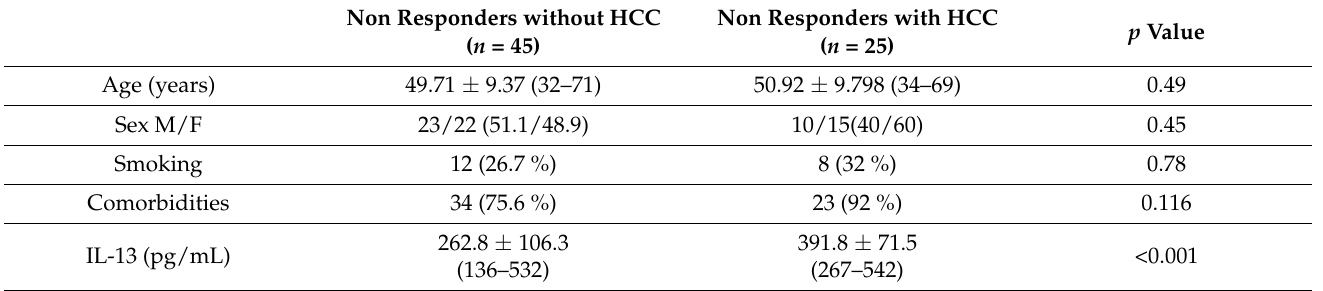
Table 2. Comparison between non-responders with and without HCC.